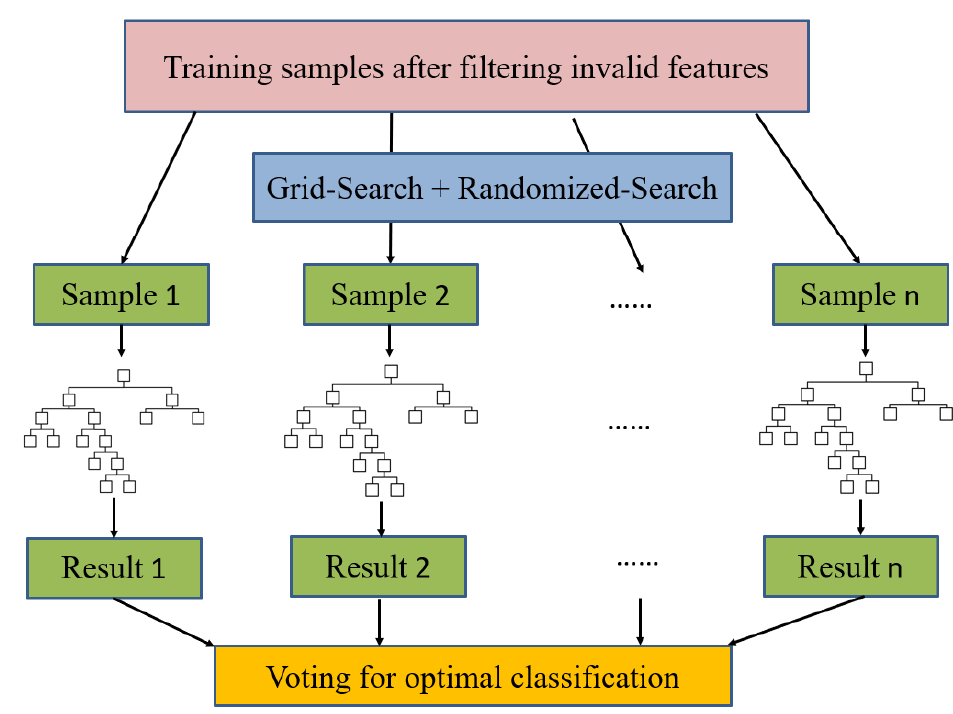
Figure 10. The architecture of the improved random forest model.